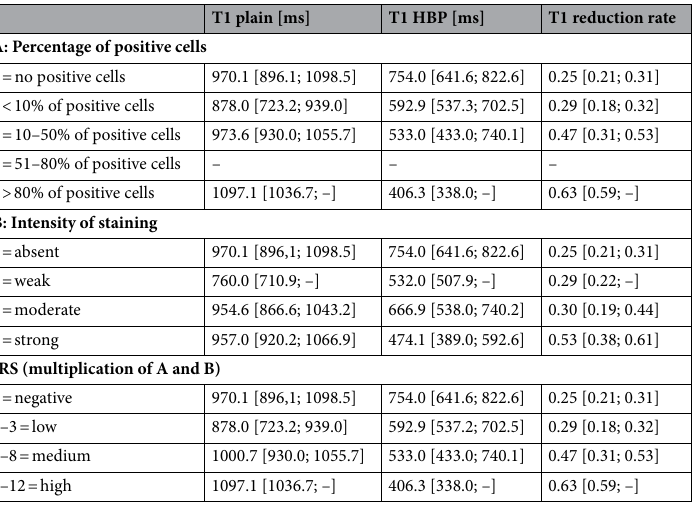
Table 4. T1 relaxation times and reduction rates for in correlation of the Immunoreactive score (IRS). The values indicate the median [q1;